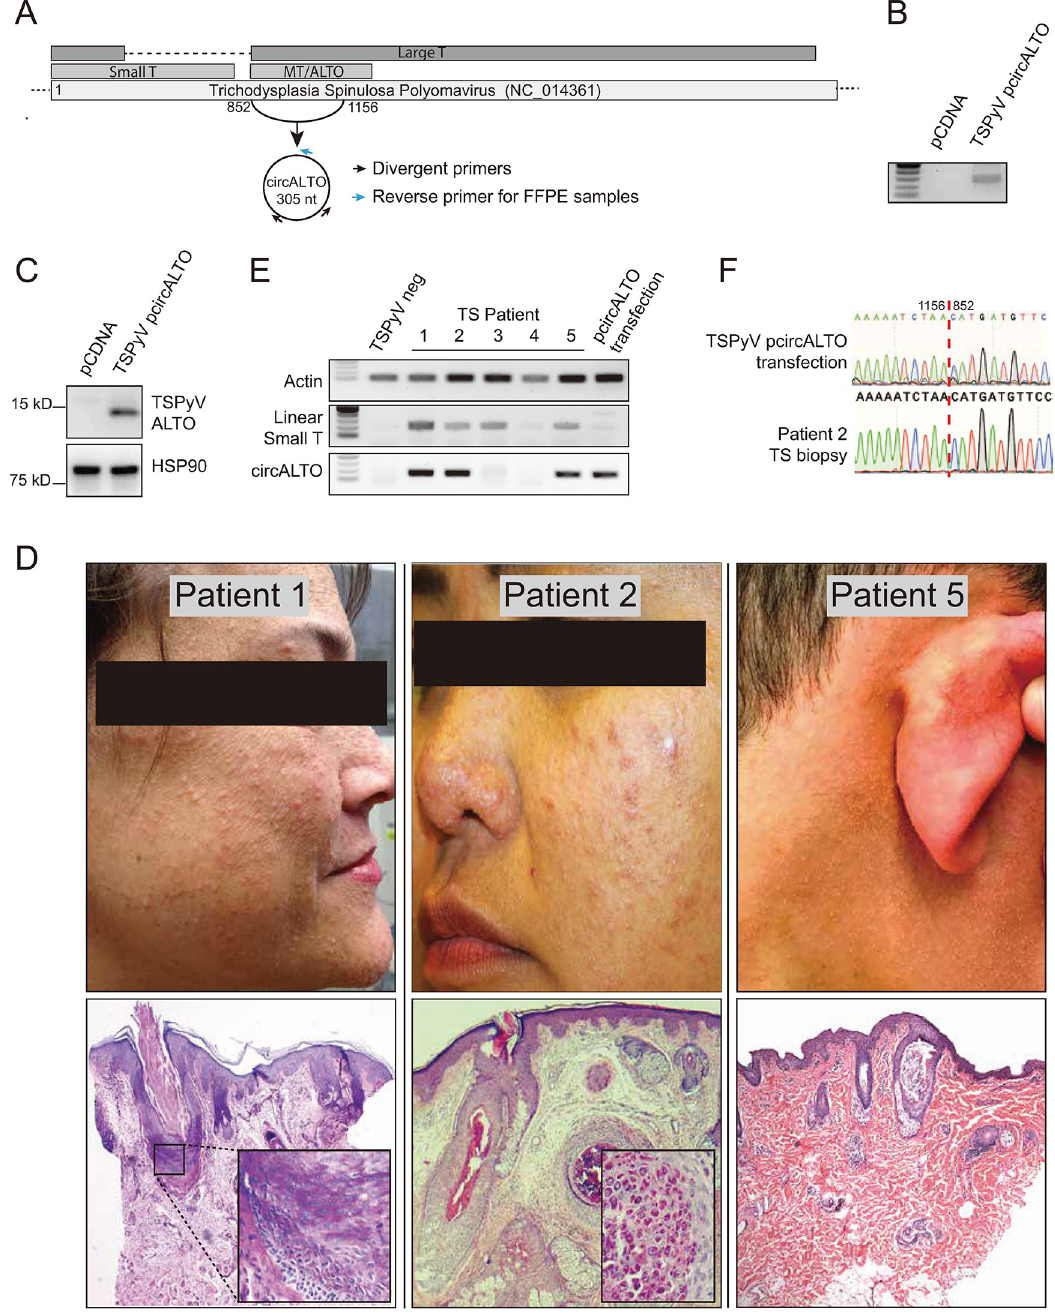
Fig 7. Conservation of circALTO in TSPyV. (A) Schematic representation of a predicted circALTO in TSPyV. Diagram highlights the location of the divergent primers used to detect TSPyV circALTO. (B). RT-PCR analysis of cDNA prepared from total RNA prepared with random hexamer primers. 293T cells were transfected with pCDNA vector or a construct containing the potentially backspliced early region of TSPyV. Total RNA was first treated with RNase R. (C) Western blot for TSPyV ALTO from 293T cells transfected with a pCDNA vector or the TSPyV circALTO construct. Lysates were probed with a polyclonal antibody generated against 2 peptides specific to the TSPyV ALTO, pAbMT [14]. HSP90, loading control. (D) Images from cases of TS identified in this study. Clinical images (top) from TS patients 1, 2, and 5. The photos show the characteristic folliculocentric papules on the face and neck. Histological images (bottom) show the H&E stained image of lesional skin from patients 1, 2, and 5. Affected skin shows dysmorphic hair follicles. Patient 1 inset shows expansion of inner root sheath (IRS). Patient 2 inset shows enlarged trichohyaline granules in IRS cells. (E) Total RNA was extracted from lesional biopies and cDNA prepared with random hexamer primers. RT-PCR analysis using indicated primers revealed the presence of linear small T (sT) in 4/5 TS samples and circALTO in 3/5 TS